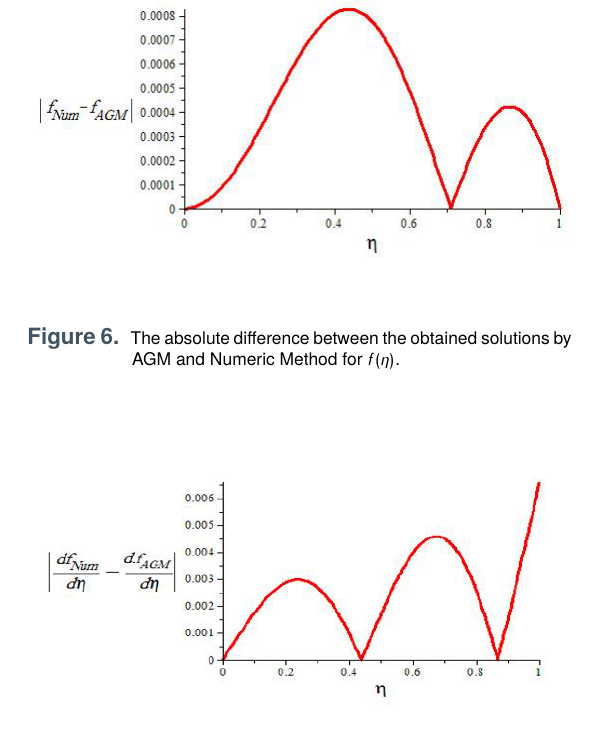
Figure 7. Theabsolutedifferencebetweentheobtainedsolutionsby AGM and Numeric Method for f 0 ( η ) .